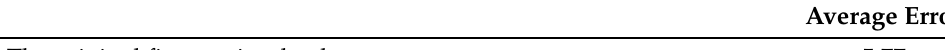
Table 2. Position errors (m).